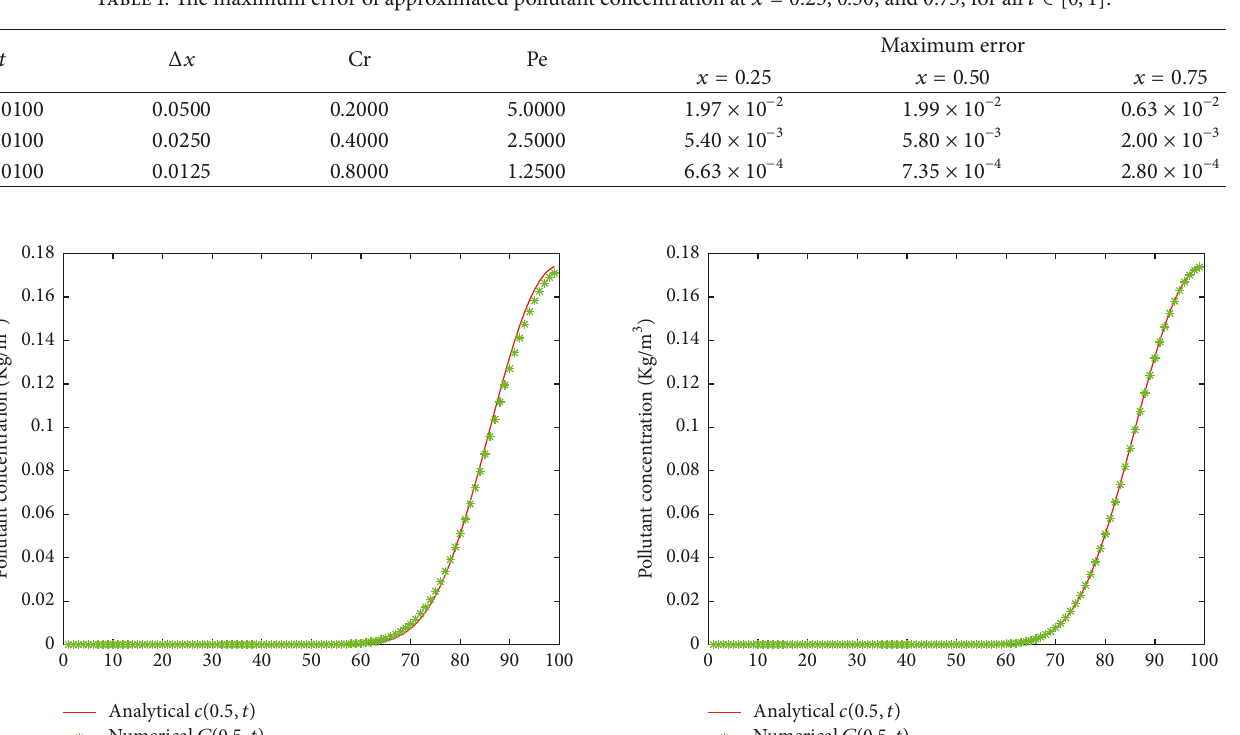
Table 1: The maximum error of approximated pollutant concentration at 𝑥 = 0.25 , 0.50 , and 0.75 , for all 𝑡 ∈ [0, 1] .